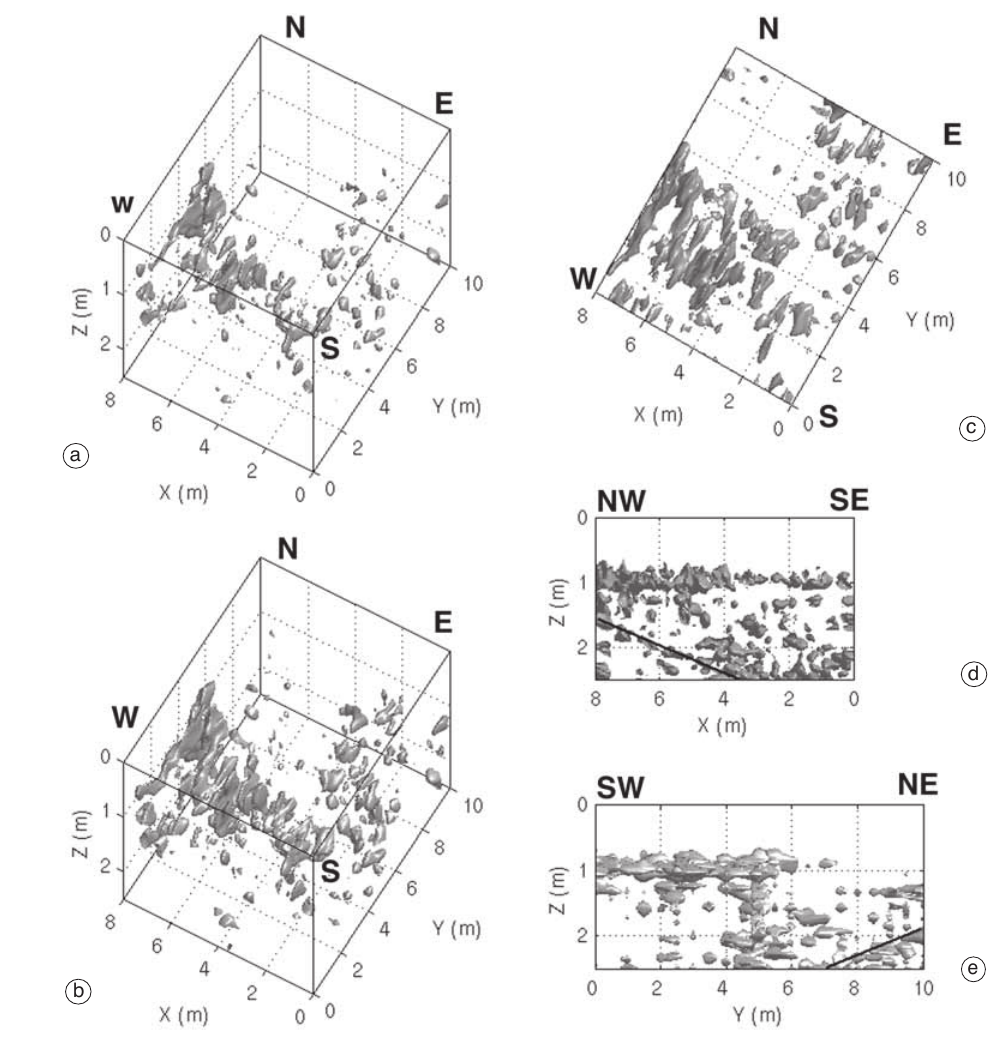
Fig. 9a-e. Zone B. 3D visualization by means of iso-amplitude surfaces of the complex trace amplitude. Perspective views (from the south) using different thresholds: 42% (a) and 37% of the maximum (b), and different views using the same threshold (37%): plan (c), front (d) and lateral view (e); the lines denote anomaly alignments probably related to dipping